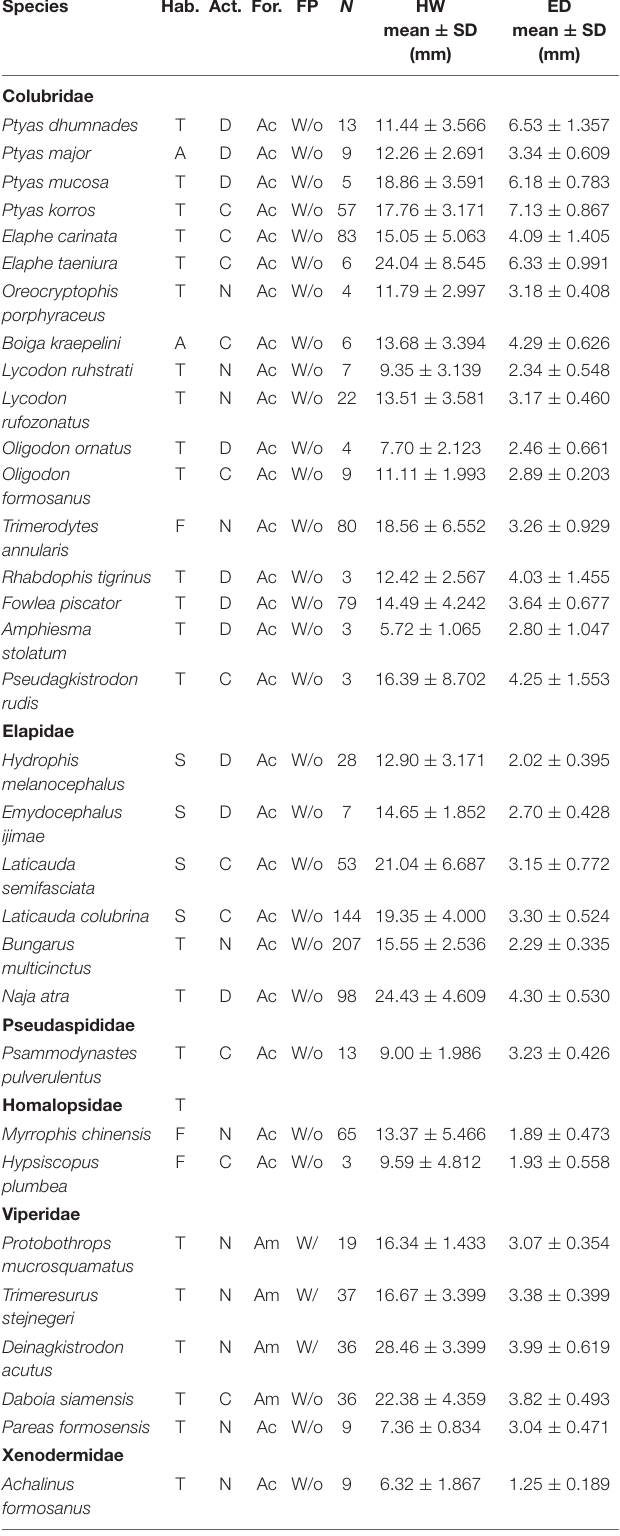
TABLE 1 | Summary of the behavioral characteristics, head width and eye diameter of the 33 snake species from Taiwan used in this study. Species Hab. Act. For. FP N